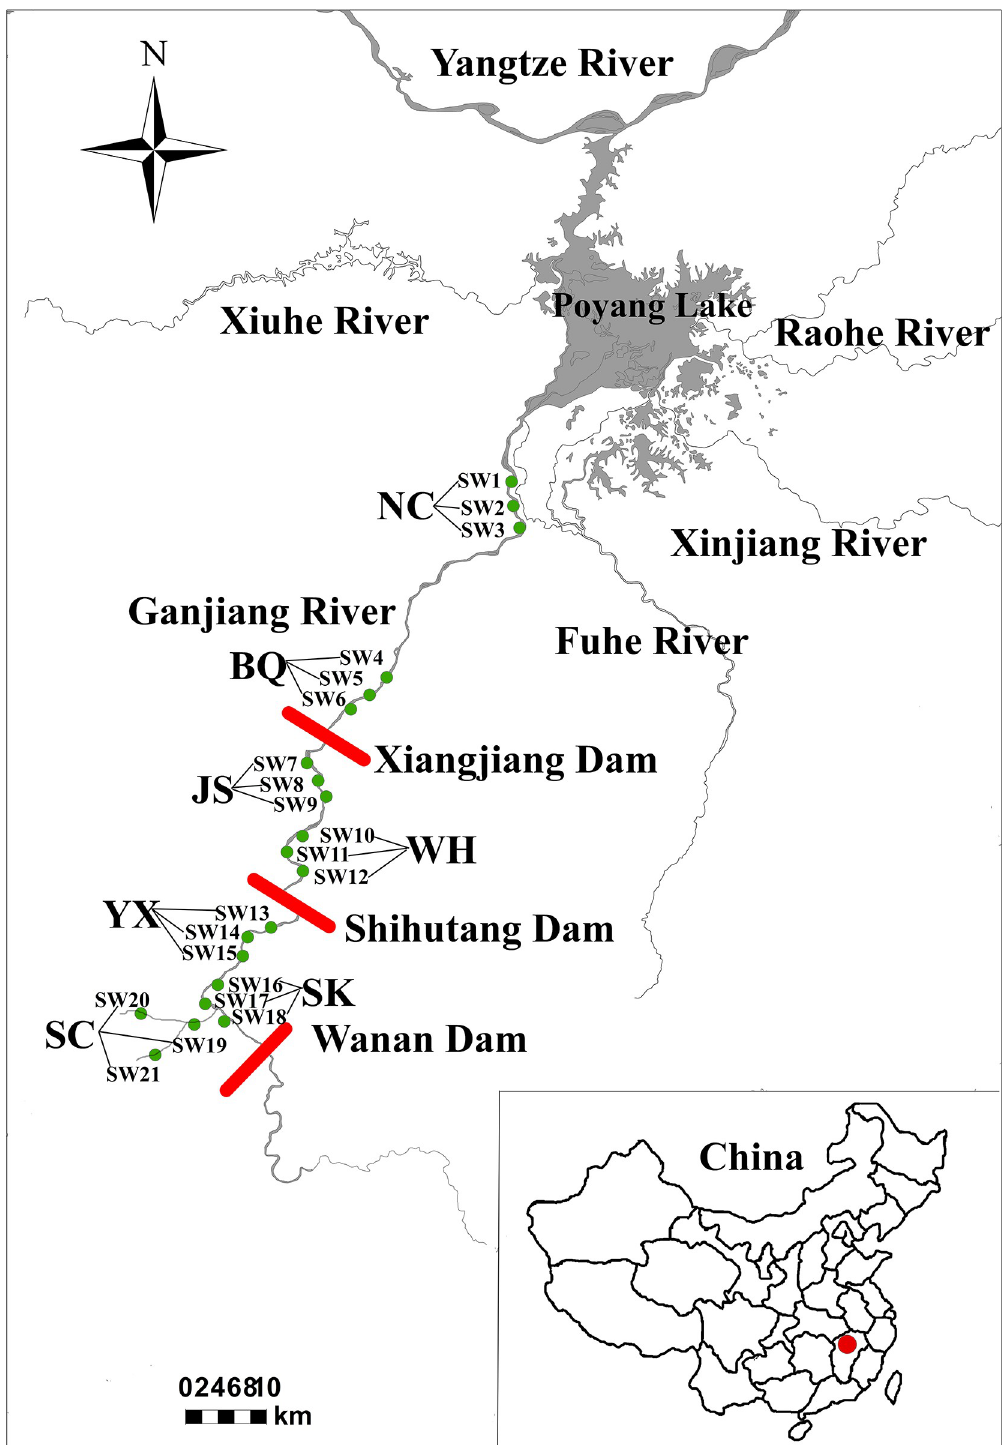
Fig 1. Sampling sections locations in the middle and lower reaches of the Ganjiang River. NC: Nanchang; BQ: Baqiu; JS: Jiangsha; WH: Wanhe; YX: Yanxi; SK: Shukou; and SC: Suichuan.